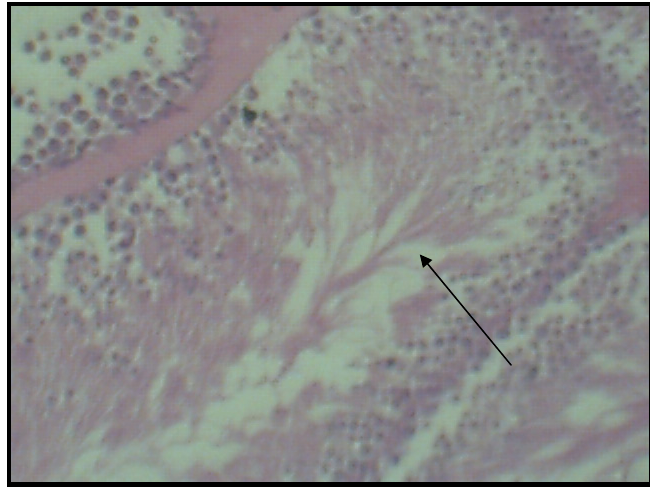
FIGURE 4 - Photomicrography of an adult hamster seminiferous tubules after treatement with finasteride. Remarcable seminiferous tubules atrophy (arrows) (HE 10x).